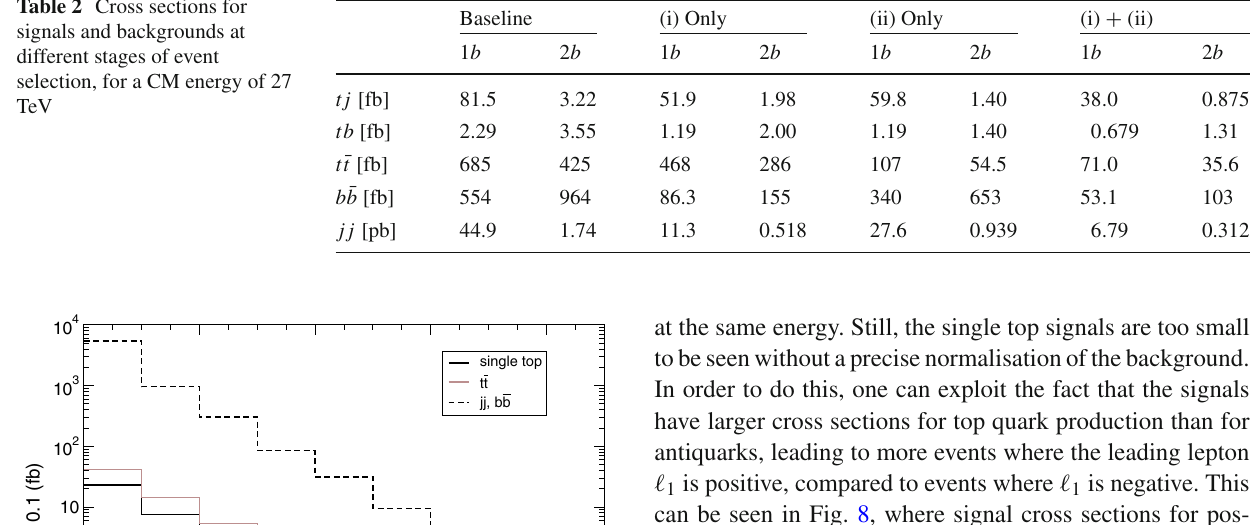
Table 2 Cross sections for signals and backgrounds at different stages of event selection, for a CM energy of 27 TeV